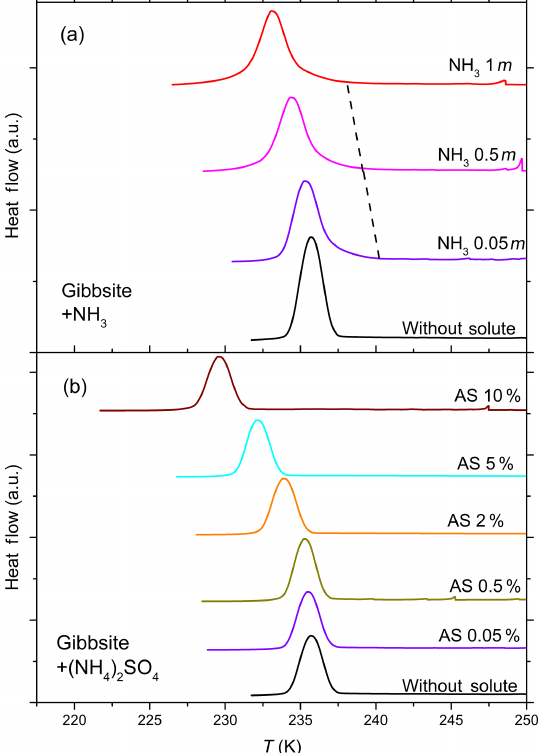
Figure 4. DSC thermograms of 10wt% gibbsite suspended in am- monia solution droplets (a) of concentrations from 0 to 1molal ( a w = 1–0.981) and ( NH 4 ) 2 SO 4 solution droplets (b) from 0 to 10wt% ( a w equal to 1–0.961). All curves are normalized such that the areas under the heterogeneous and homogeneous freezing curves sum up to the same value. Gibbsite shows no discernible het- erogeneous freezing signal in pure water and starts to show a weak heterogeneous freezing signal when suspended in ammonia solution (dashed black line connects the onset of heterogeneous freezing sig- nals), while no heterogeneous IN is observed for gibbsite suspended in ( NH 4 ) 2 SO 4 .